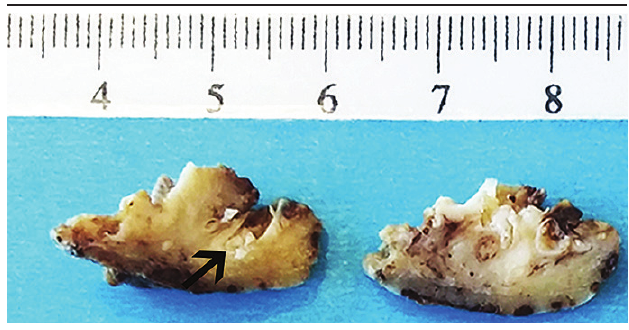
figurE 3 − Macroscopic view of the surgical specimen showing several white areas, which correspond to keratin formation, reaching the basal portion of the mandible. The arrow shows the typical “rabbit burrow”, which by microscopy showed similar histopathological features to those in Figure 2C